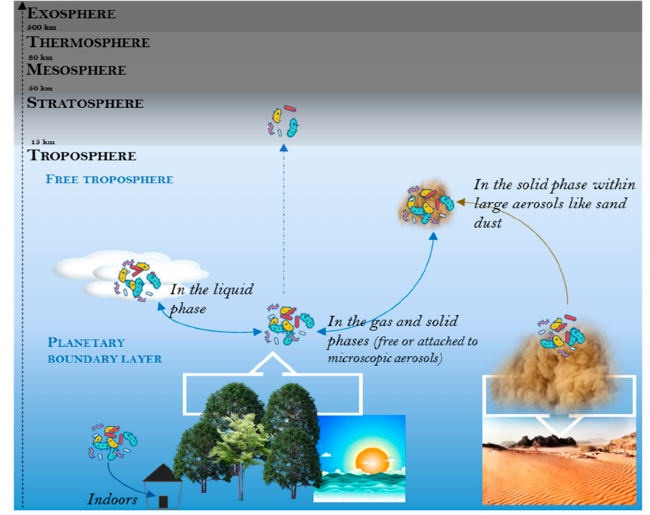
Figure 1. The different biological niches investigated in aeromicrobiology. These different niches might exchange microorganisms and represent different physico-chemical conditions for airborne microorganisms.